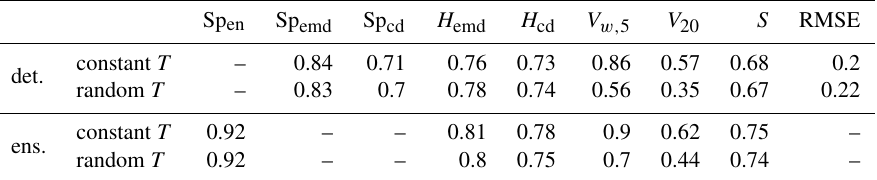
Table 5. Fraction of cases where the correct forecast received the best score. Top two rows: deterministic forecasts with and without perturbed threshold. Bottom: ensemble forecasts with and without perturbed thresholds. Sp en Sp emd Sp cd H emd H cd RMSE constant T – 0.84 det. random T constant T 0.92 ens. random T